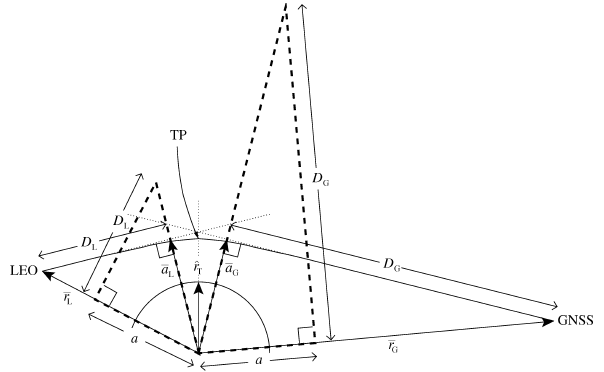
Figure 3. Illustration of the occultation geometry showing a ray path between the GNSS and Fig. 3. Illustration of the occultation geometry showing a ray path LEO satellites with indication of the tangent point (TP). The ray asymptotes and a line from between the GNSS and LEO satellites with indication of the tangent the origin through the TP are indicated by thin dotted lines. The two dash-lined right-angled point (TP). The ray asymptotes and a line from the origin through triangles are equivalent (but mirrored and rotated) to the two right-angled triangles defined by the TP are indicated by thin dotted lines. The two dash-lined right- the ray asymptotes and the satellite positions. The partial circle denotes a radius of unit length angled triangles are equivalent (but mirrored and rotated) to the two and origin at the center of refraction. right-angled triangles defined by the ray asymptotes and the satel- lite positions. The partial circle denotes a radius of unit length and origin at the center of